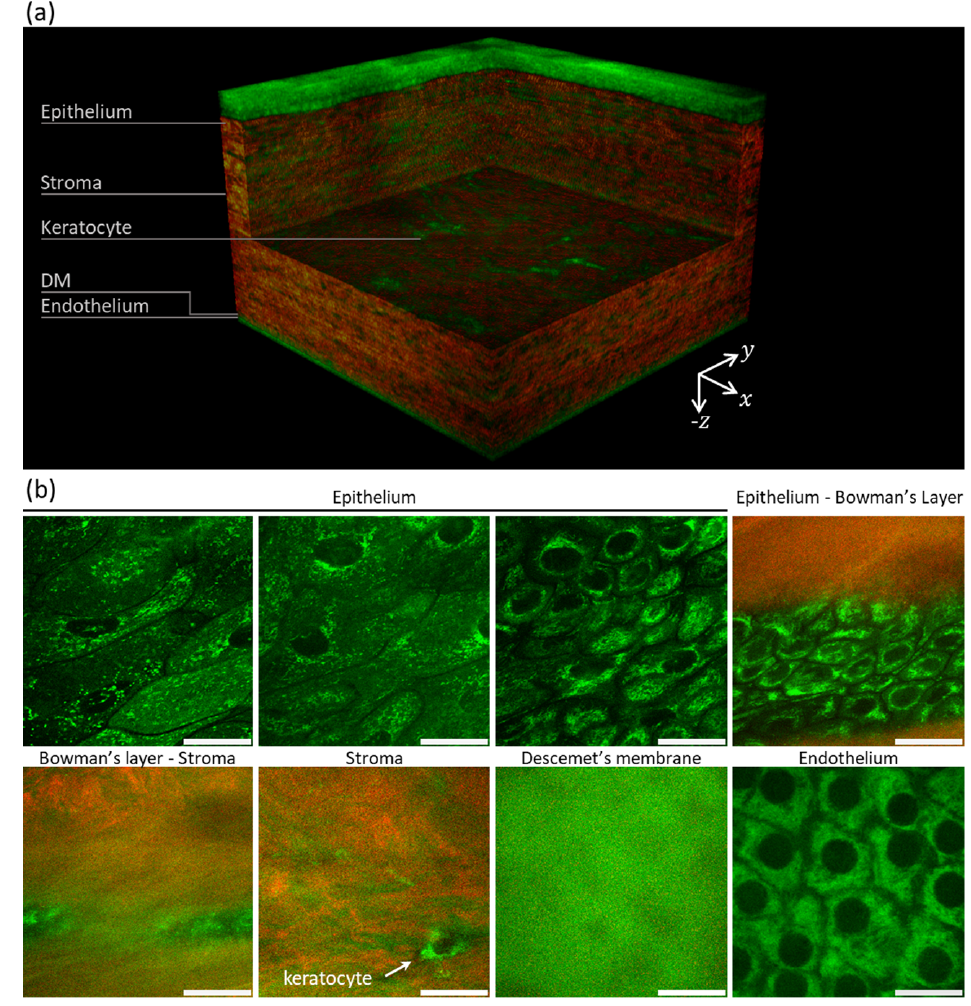
Figure 6. 3D composite representation of the porcine cornea reconstructed from autofluorescence (green) and second-harmonic generation (red) images of the tissue ( a ), and depth-wise en-face images of the human cornea autofluorescence (green) and second-harmonic generation (red) ( b ). Images were acquired with the multiphoton tomograph MPT flex (JenLab, GmbH) using an excitation wavelength of 760 nm. Scale bars = 20 µ